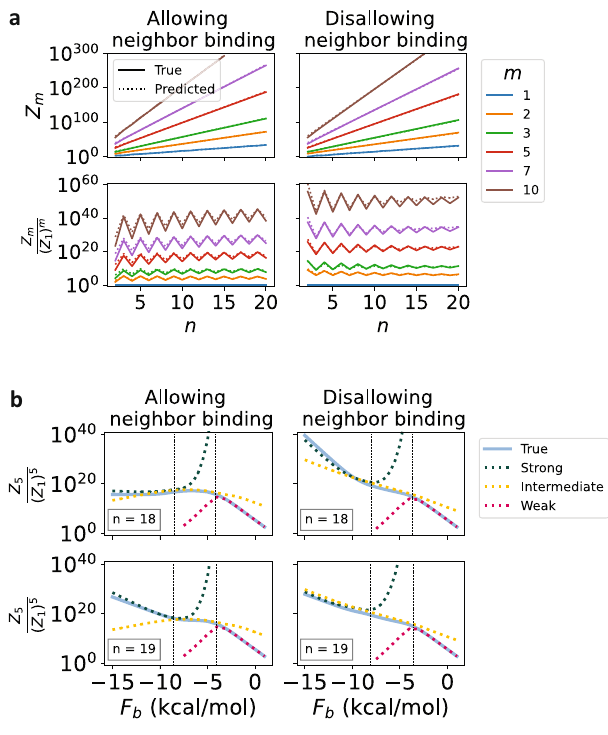
Fig. 2 | Analytical model demonstrates good agreement with computational results. a As a function of number of stickers per strand : Partition functions and partition function ratios are plotted with respect to n using the exact computa- tional (solid) and simpli fi ed analytical (dotted) models. A single fi tting parameter wasused forthe analyticalmodels, fi t tothemonomerpartition function (top row, blue). The slight discrepancy in the analytical prediction for large m and n dis- allowing neighbor bonds is primarily due to the heuristic approximation of g ( n , m , N b ) from g ( nm ,1, N b ) used. b As a function of binding strength: The ratio of the pentamer partitionfunction to thatof fi ve monomers isplotted;similar results holdforanyothermultimerchosen.Theanalyticalmodelpredictionsareseparated into three regimes: strong (green), intermediate (yellow), and weak (red) binding. Vertical dashed lines separate wheredifferent regimesare expected to provide the best agreement and are calculated as the values of F b such that N ? b = N max b (cid:2) 1 and N ? b = N min b +3. A single fi tting parameter — the same one from panel ( a ) — is